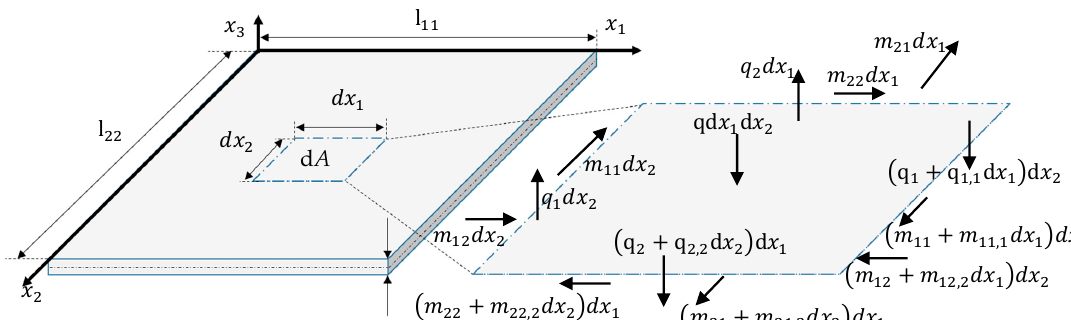
Transverse force